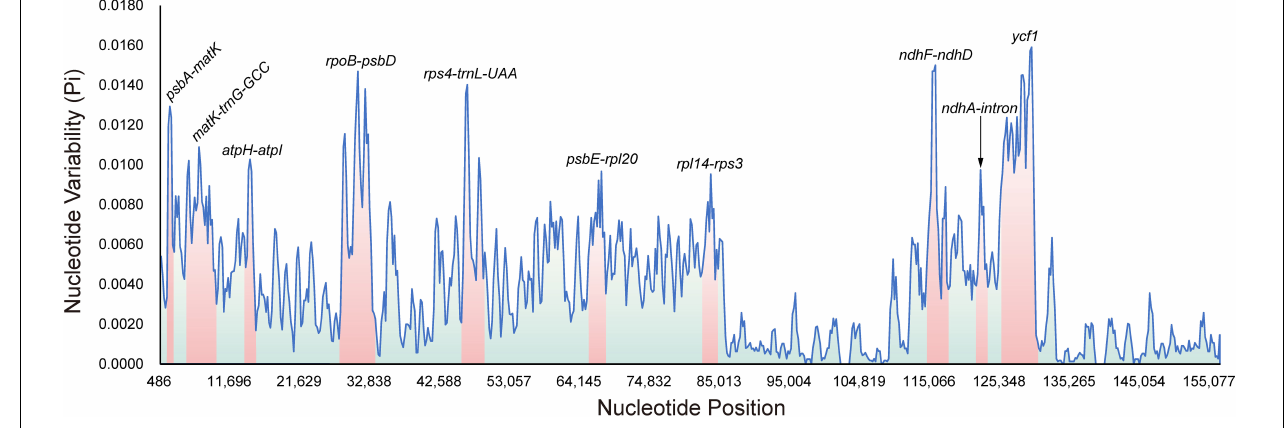
FIGURE 1 | Sliding window analysis of the 73 complete plastomes in Fritillaria (window length: 600 bp, step size: 200 bp) to show high variable regions (HVRs). X -axis: position of the midpoint of a window; Y -axis: nucleotide diversity of each window. The size of these regions is highlighted with the obviously gradient colors.